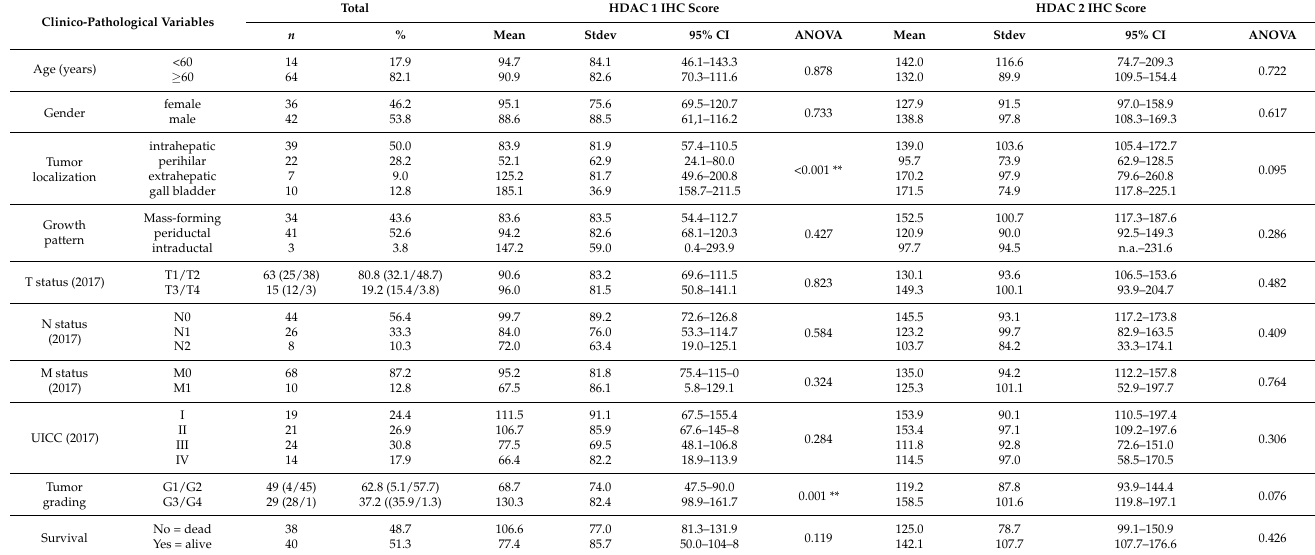
Table 3. Clinicopathological characterization of the BTC patient cohort ( n = 78) and HDAC 1 and 2 expression by immuno- histochemistry